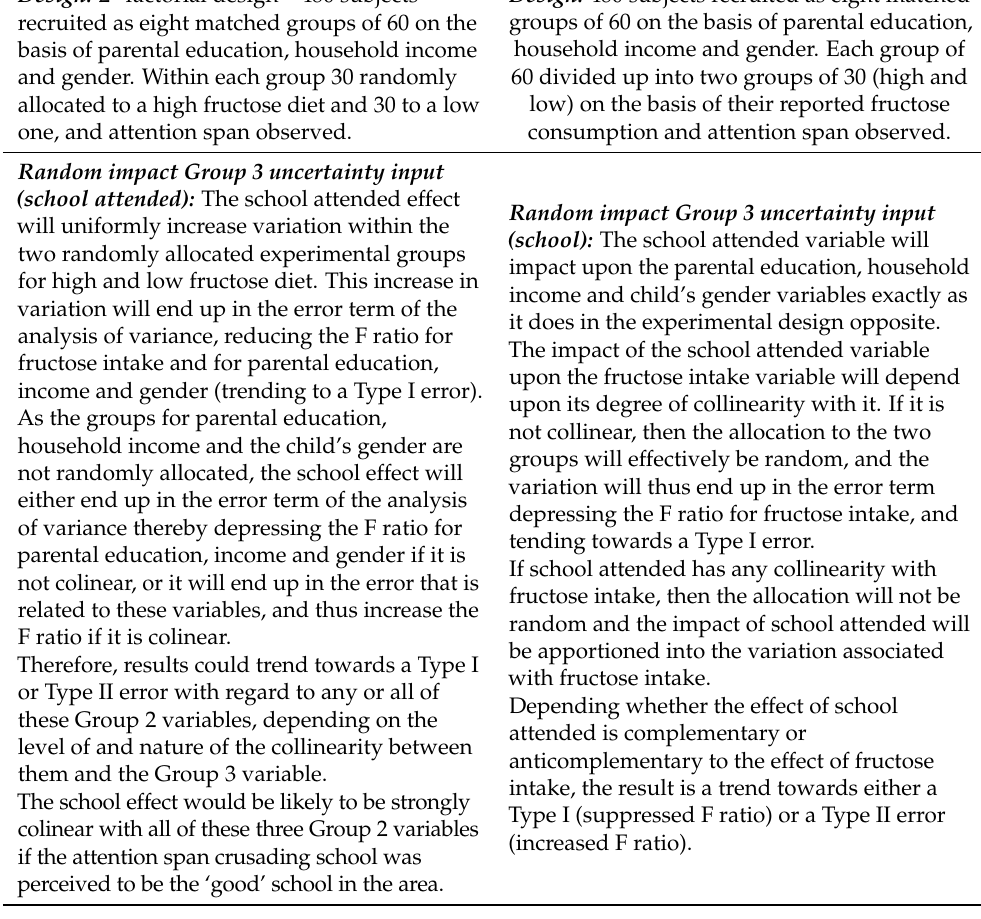
Table 2. The impact of Group 3 uncertainty variables on experimental and observational research outcomes. Experimental Study Observational